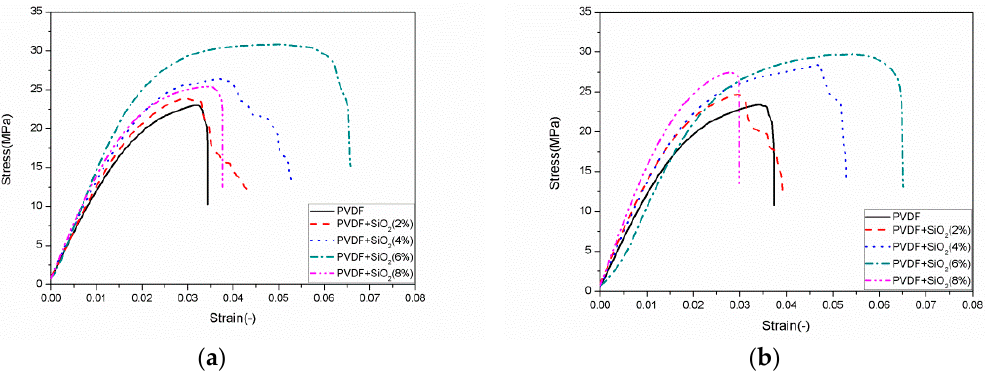
Figure 3. Stress–strain curves of notched samples at different angles: ( a ) 60°; ( b ) 120°.